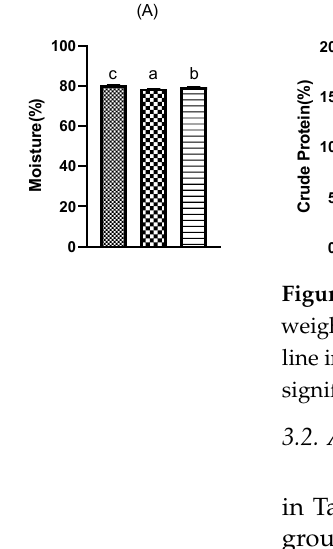
Table 2. Amino acid composition and contents in muscle of three groups (g/100 g, dry sample). Amino Acid